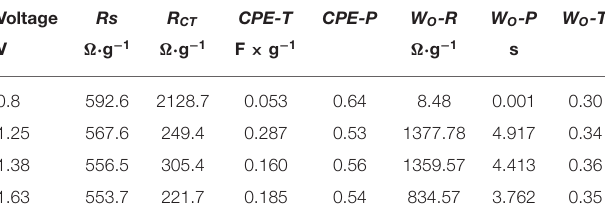
TABLE 2 | List of EIS fitting